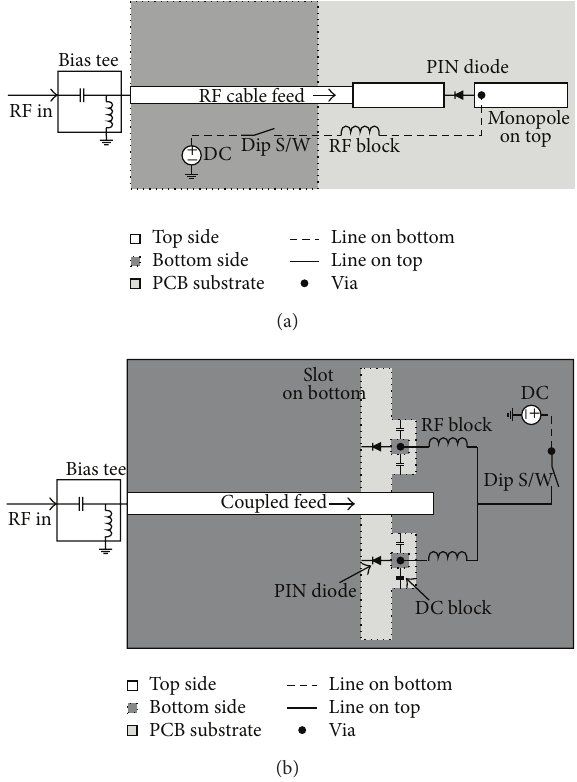
Figure 6: Configurations of the reconfigurable antenna with PIN diodes, including the biasing network; (a) the monopole antenna and (b) the slot